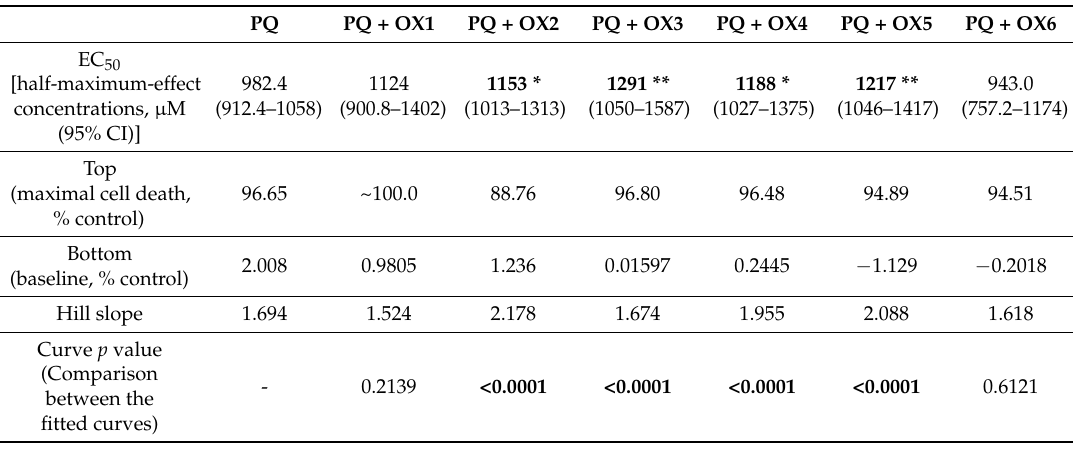
Table 1. EC 50 (half-maximum-effect concentrations), TOP (maximal effect), BOTTOM (baseline), and Hill Slope values of the paraquat (PQ) concentration—response curves, with (PQ + OXs) or without (PQ) simultaneous exposure to the six tested oxygenated xanthones, OX 1–6 (20.0 μ M).